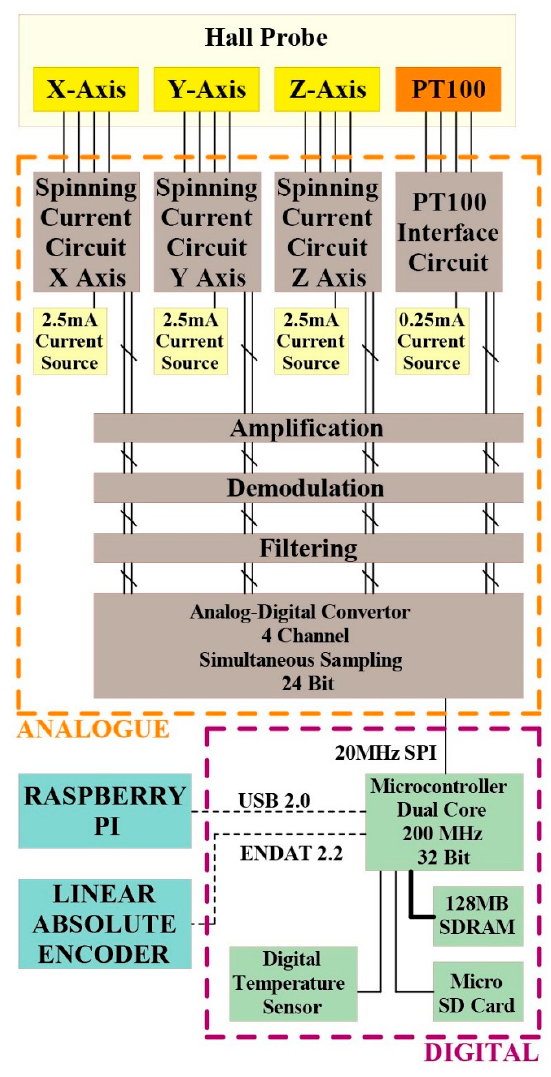
Figure 2. Block diagram of the instrument comprising the analog domain and the digital domain sections each composed of different blocks. The instrument also supports an external interface to the Raspberry Pi and the linear absolute encoder.